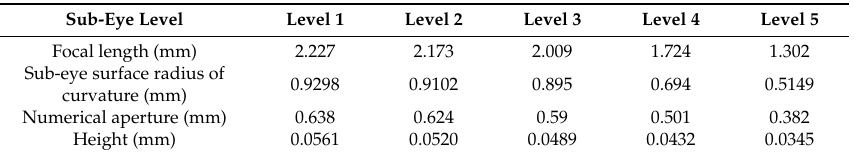
Table 4. Aspherical sub-lens microlens size